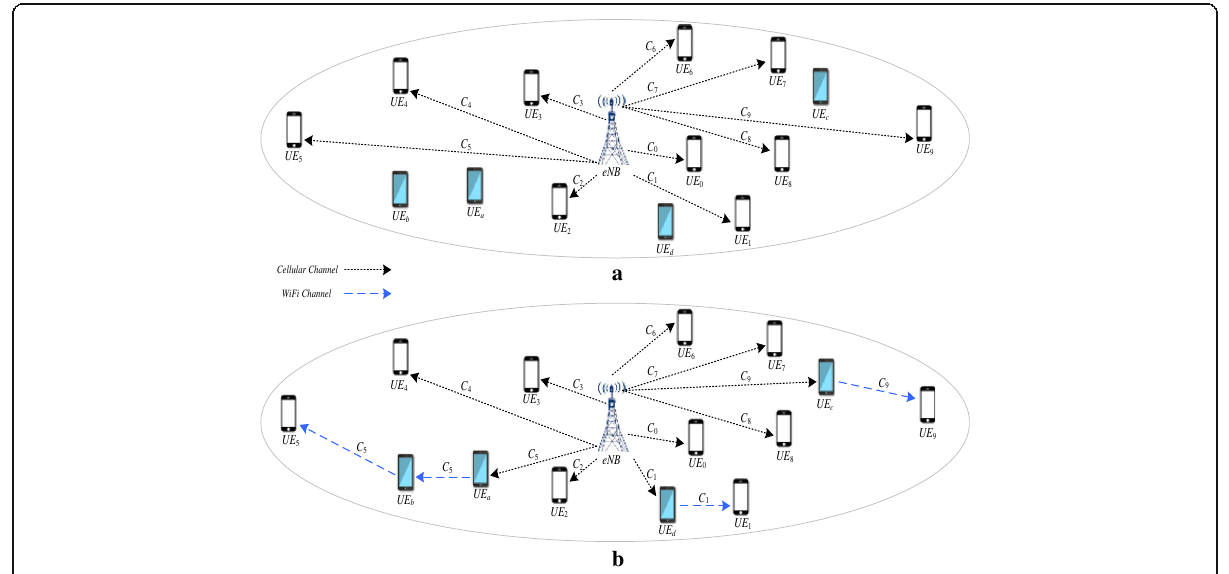
Fig. 1 Example for heterogeneous cellular networks. a The case without the usage of relays b The case with the usage of